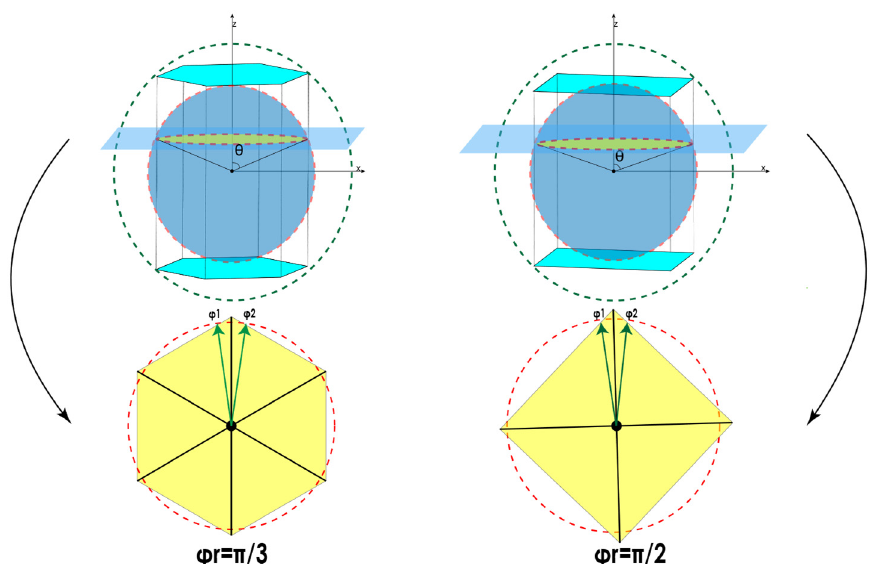
ϕ is the rotation period angle Figure 3. Particles with N-fold symmetric geometry cross section. ϕ r is the rotation period angle r